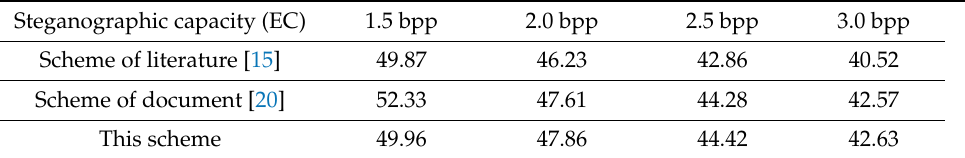
Table 8. Image steganography parameter results comparison.